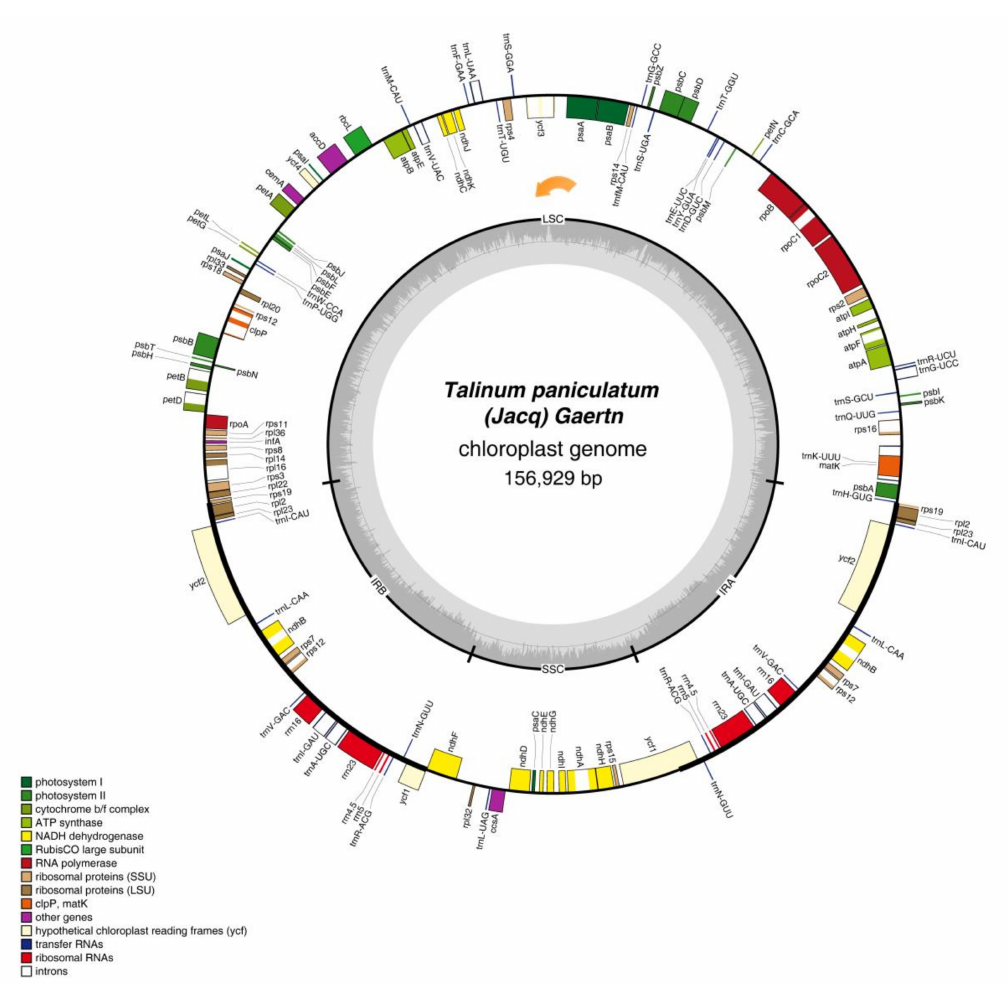
Figure 1. The complete chloroplast genome map of Talinum paniculatum (Jacp) Gaertn. Genes are color-coded based on functional group. Genes drawn inside the circle are transcribed clockwise, and those outside are transcribed counterclockwise. The genome orientation are the orange